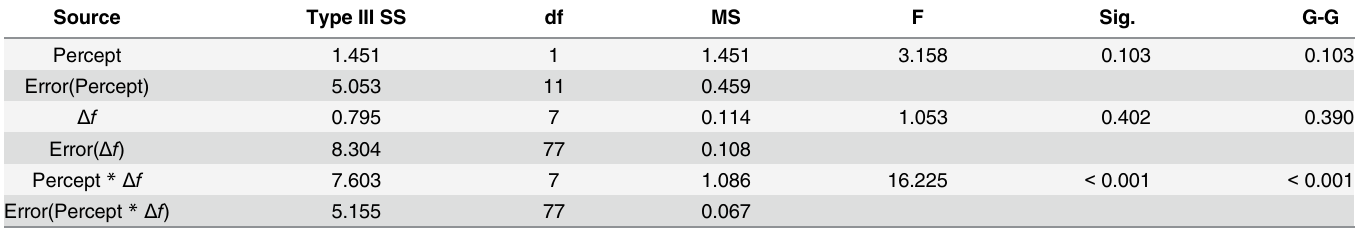
Table 4. Two-way repeated measures ANOVA of log noramlized durations for Percept type (integrated or segregated), Δ f (eight conditions) and their interaction, see Fig 9B. Analysis shows a significant interaction for Percept * Δ f . Data for N = 12 subjects, see text. Mauchly test for sphericity reaches significance for the Percept * Δ f interaction, Greenhouse-Geisser corrected P -value reported in the